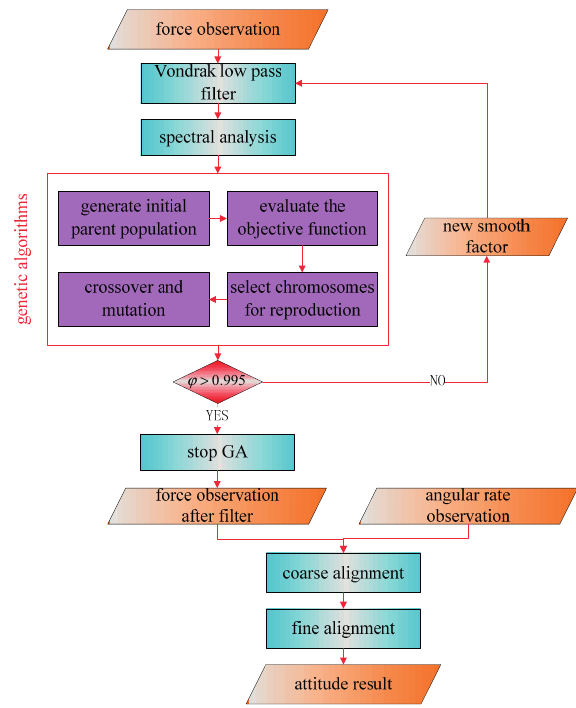
Figure 6. The improved initial alignment with a Vondrak filter for the disturbed base.